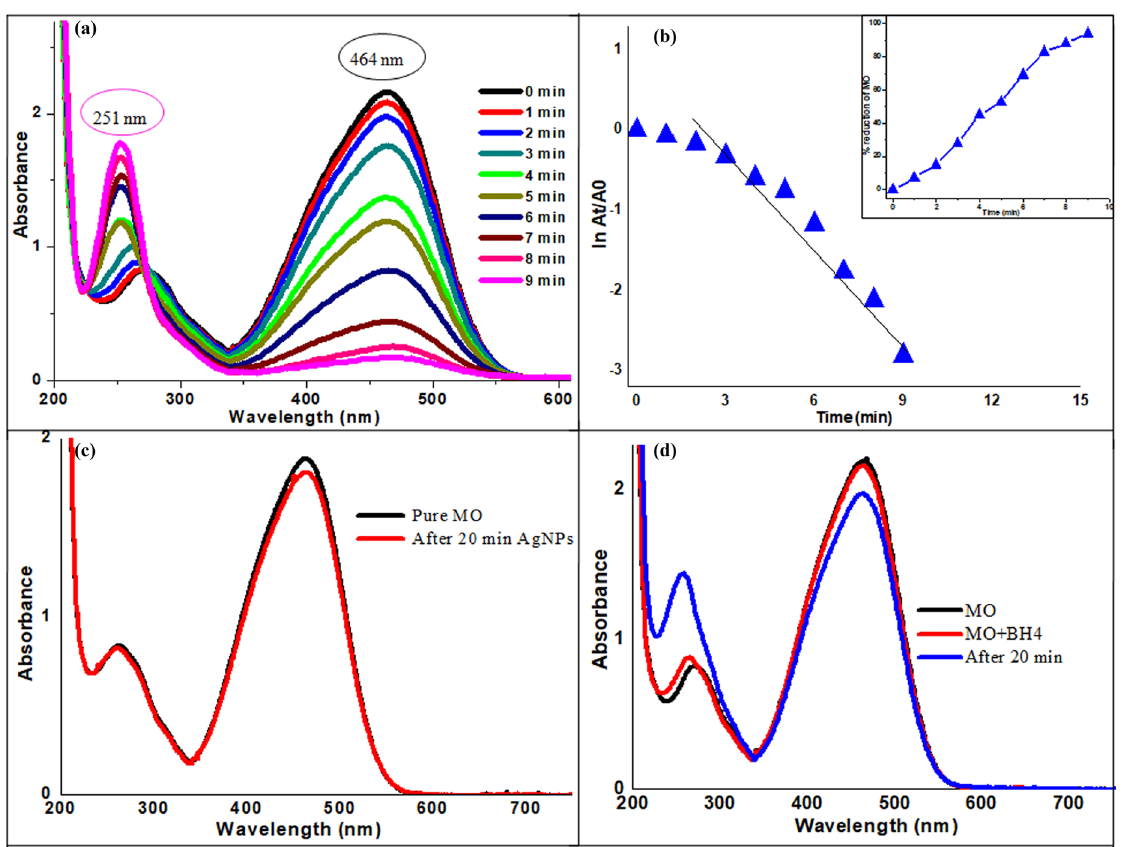
Figure 8: ( a ) Catalytic reduction of MO by AgNPs and NaBH4, ( b ) ln A t / A 0 of the MO by AgNPs and NaBH 4 ( inset show percent reduction of MO ) , ( c ) MO reduction by AgNPs alone, ( d ) MO reduction by NaBH 4